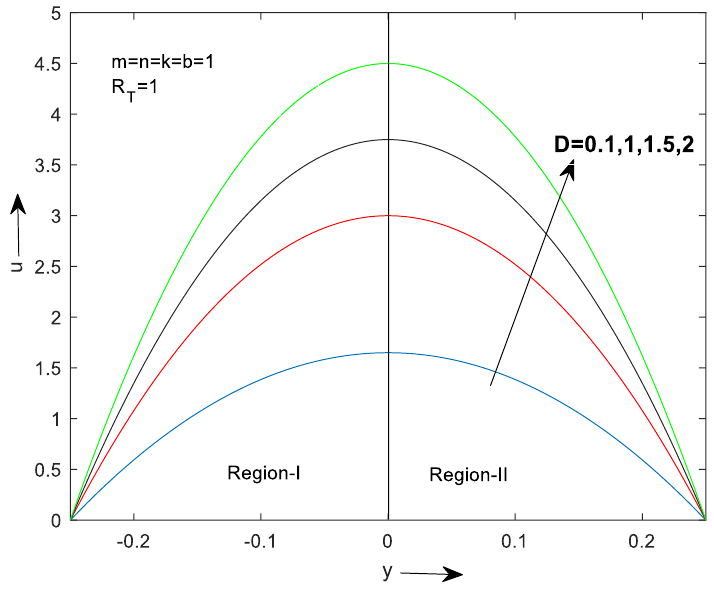
Fig. 6a. Velocity profile for different values of D.